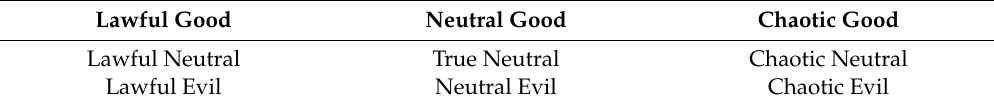
Table 2. Alignment Matrix in Dungeons and